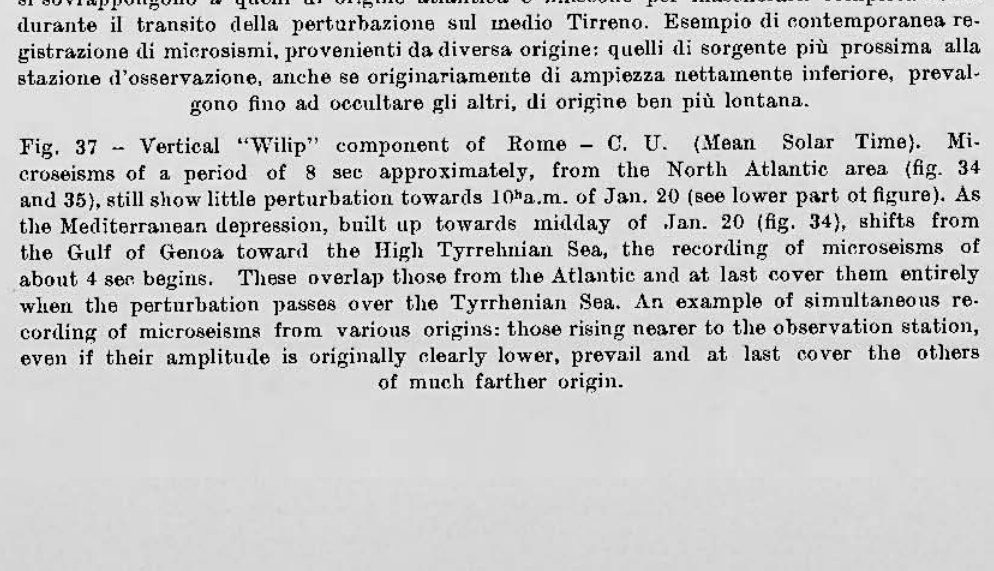
Fig. 37 _ Vertical "·Wilip" component of Rome - C. U. (1Iean Solar Time).